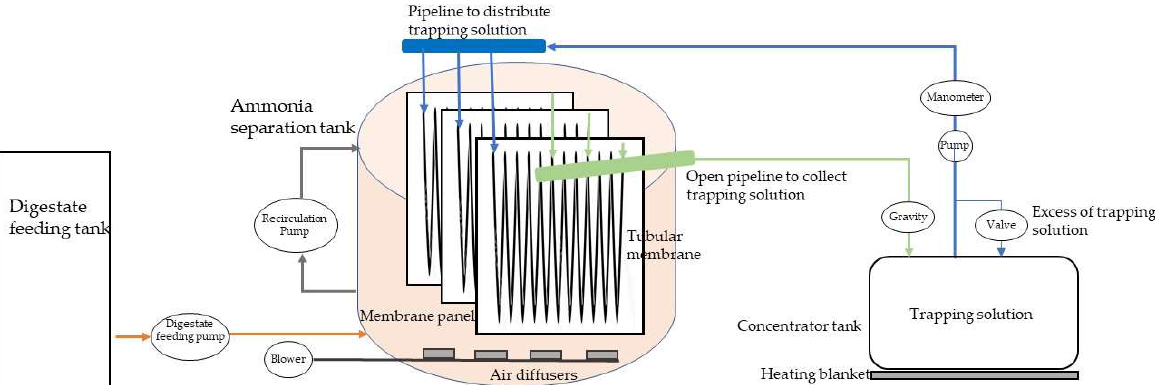
Figure 2. Schematic diagram of the pilot plant.